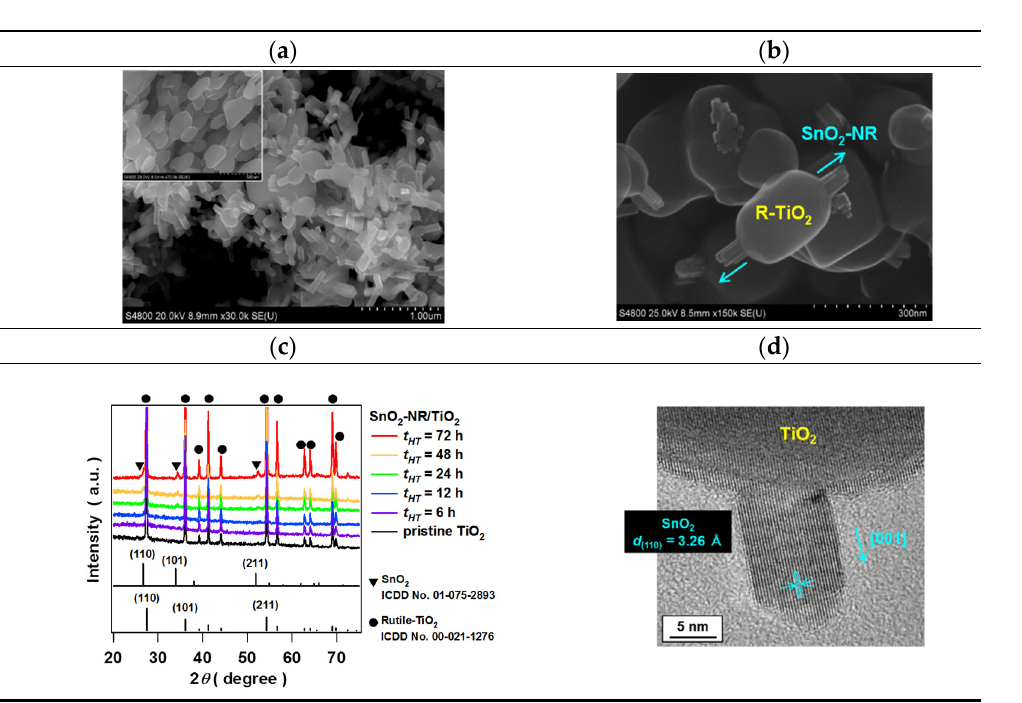
Figure 3. Low ( a ) and high ( b ) magnification SEM images for SnO 2 -NR/TiO 2 (t HT = 72 h). The inset in ( a ) shows SEM image for pristine rutile TiO 2 . ( c ) XRD patterns for SnO 2 -NR/TiO 2 , and pristine TiO 2 for comparison. ( d ) HR-TEM image for SnO 2 -NR/TiO 2 . The figure is taken from ref. [16].